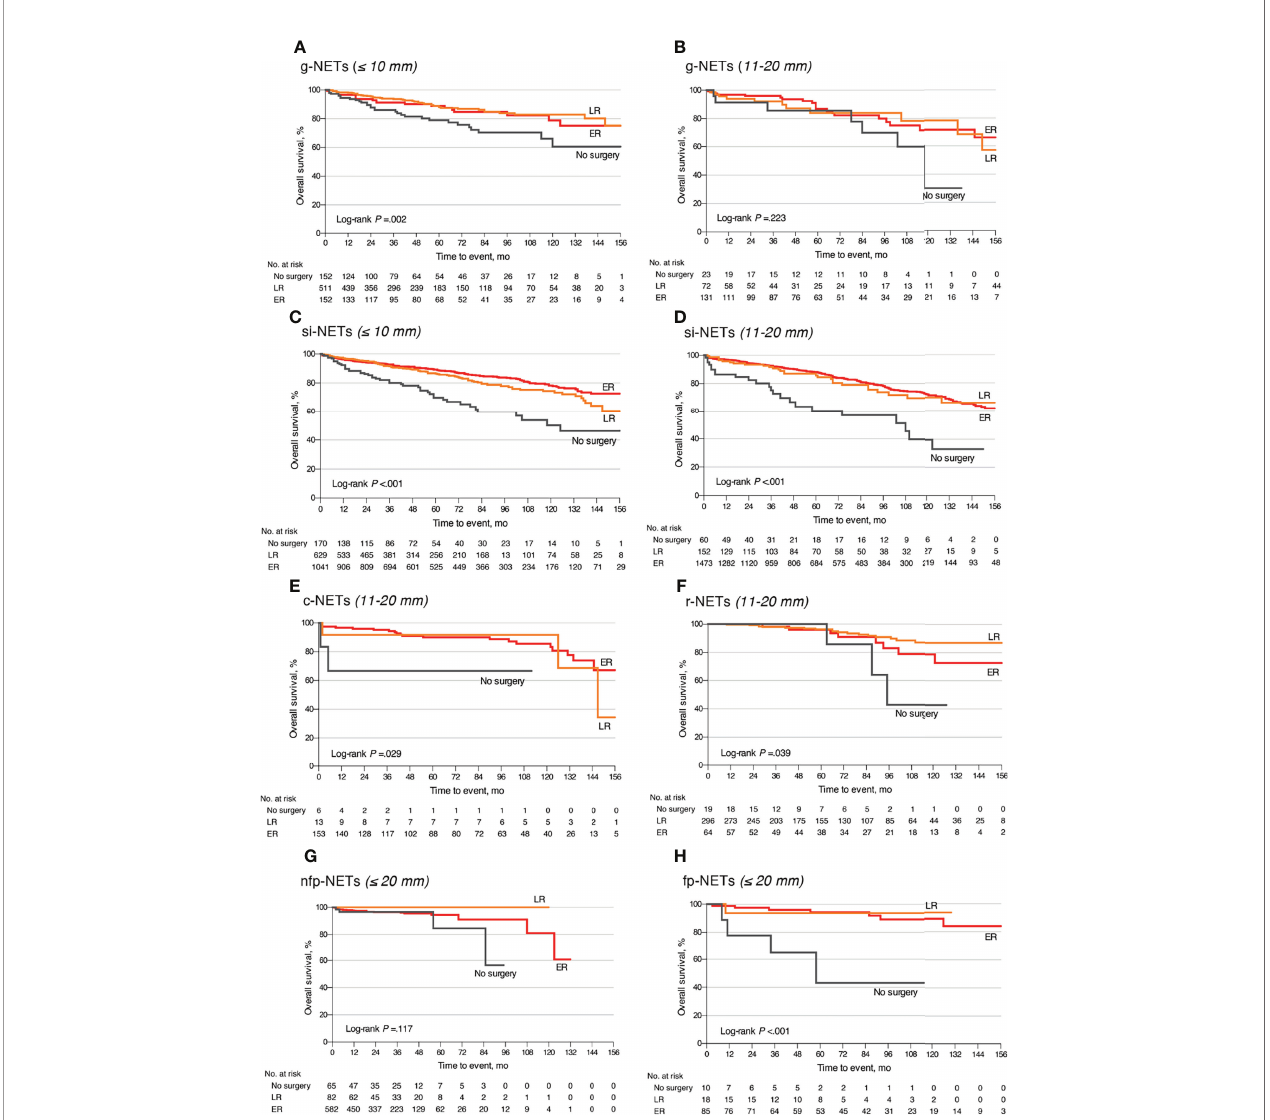
FIGURE 2 | Overall survival comparison of different surgical strategies strati fi ed by tumor location and size among patients with small well-differentiated GEP-NETs. (A) The g-NETs of the ≤ 10 mm cohort; (B) the g-NETs of the 11 – 20 mm cohort; (C) the si-NETs of the ≤ 10 mm cohort; (D) the si-NETs of the 11 – 20 mm cohort; (E) the c-NETs of the 11 – 20 mm cohort; (F) the r-NETs of the 11 – 20 mm cohort; (G) the nfp-NETs of the ≤ 20 mm cohort; and (H) the fp-NETs of the ≤ 20 mm cohort. GEP-NETs, gastroenteropancreatic neuroendocrine tumors; LR, local resection; ER, extended resection; g-NETs, gastric neuroendocrine tumors; si-NETs, small intestinal neuroendocrine tumors; c-NETs, colonic neuroendocrine tumors; r-NETs, rectal neuroendocrine tumors; nfp-NETs, non-functional pancreatic neuroendocrine tumors; fp-NET, functional pancreatic neuroendocrine